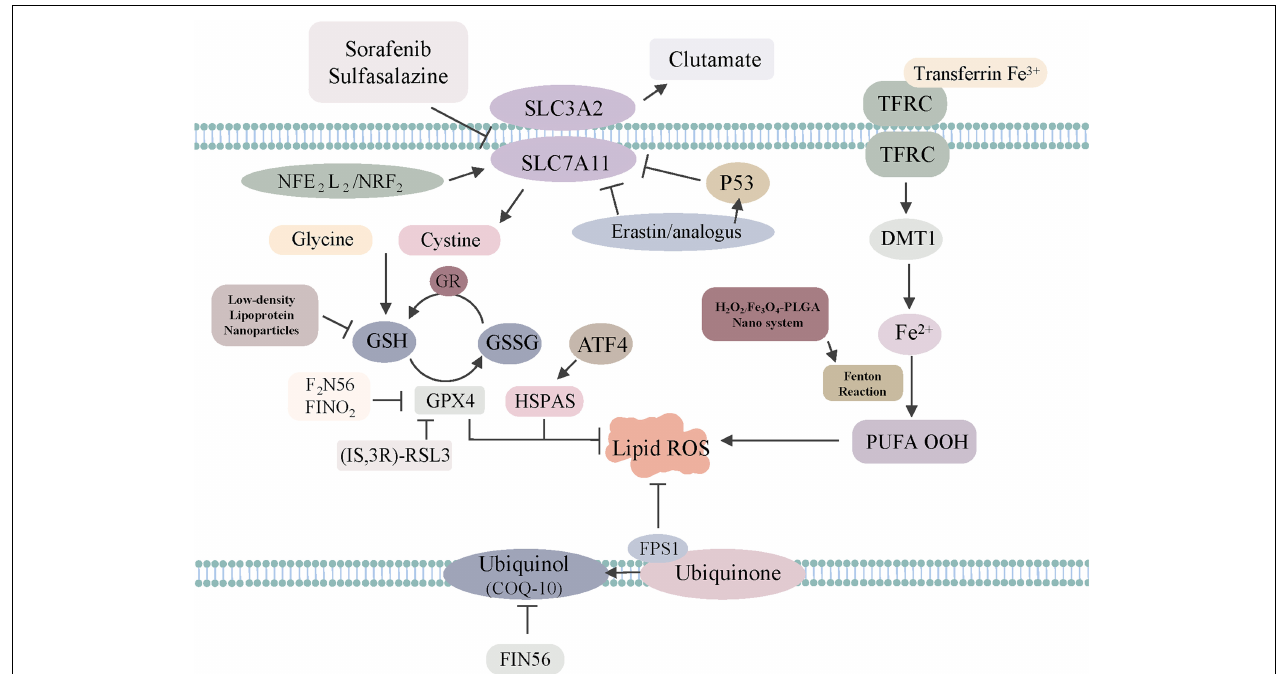
FIGURE 1 | The regulatory mechanisms of ferroptosis-related drugs or genes. Sorafenib, sulfasalazine, erastin/analogs and p53 inhibit SLC7A11 to trigger ferroptosis. GPX4 is directly inhibited by (1S, 3R)-RSL3, F2N56, FINO2, HSPAS. NADPH–FSP1–CoQ10 ferroptosis surveillance pathway acts in parallel to the GPX4 pathway. Low-density, lipoprotein, Nanoparticles can regulate GSH to induce ferroptosis. H 2 O 2 /Fe 3 O 4 -PLGA nanosystem can regulate Fenton reaction to induce